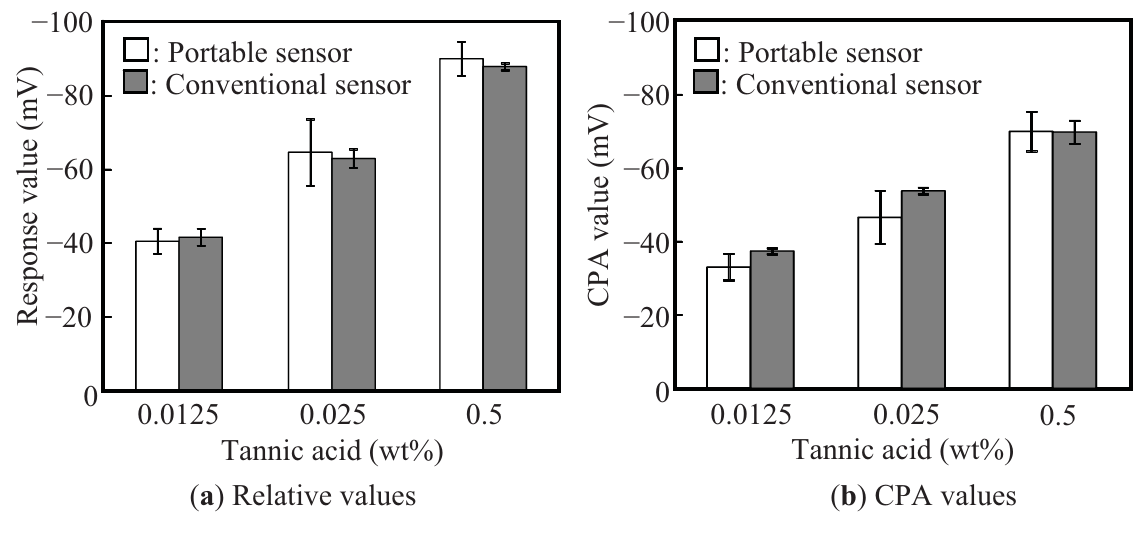
Figure 4. Response of the portable taste sensor to tannic acid. ( a ) Relative values. ( b ) CPA